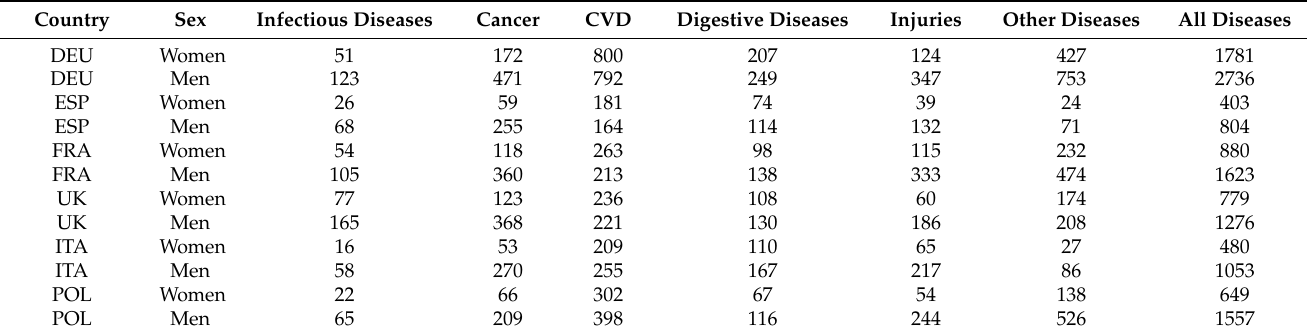
Table A1. Causes of death averted by a 10% reduction of alcoholic strength in 2019 by country and sex.